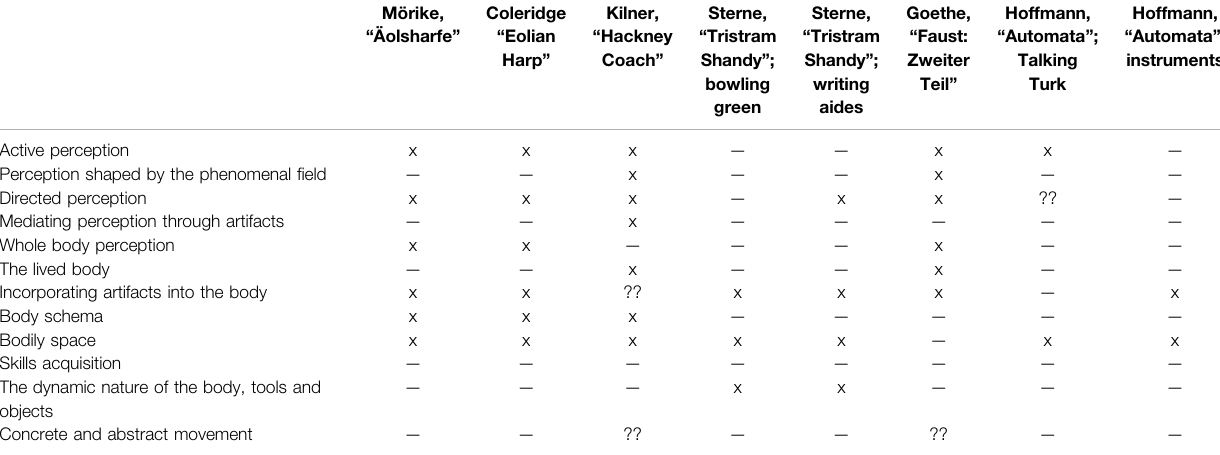
TABLE 3 | Analysis of works by embodiment criteria adapted from Svanæs (2013).